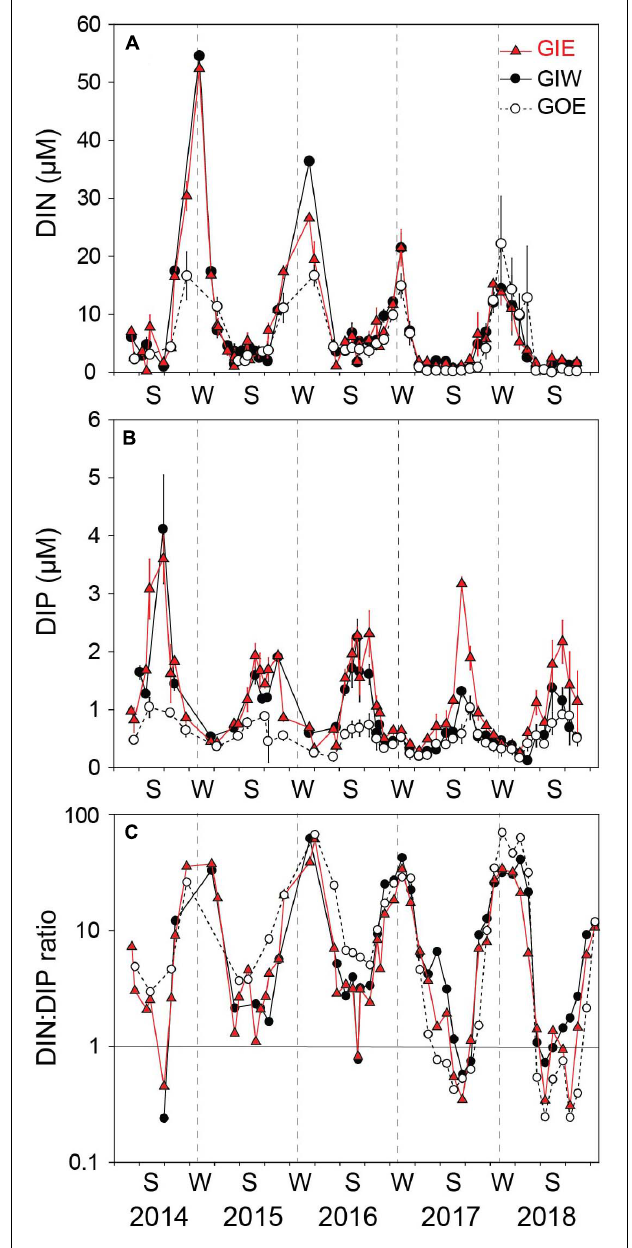
FIGURE 6 | (A) DIN concentration, (B) DIP concentration, and (C) DIN:DIP ratio in the overlying water at station GIE, GIW, and GOE in Gyldensteen Coastal Lagoon from April 2014 to December 2018. Values are given as average ± se of triplicates sampled once every 1–3 months from April 2014 to June 2016 and triplicate monthly samples every month after